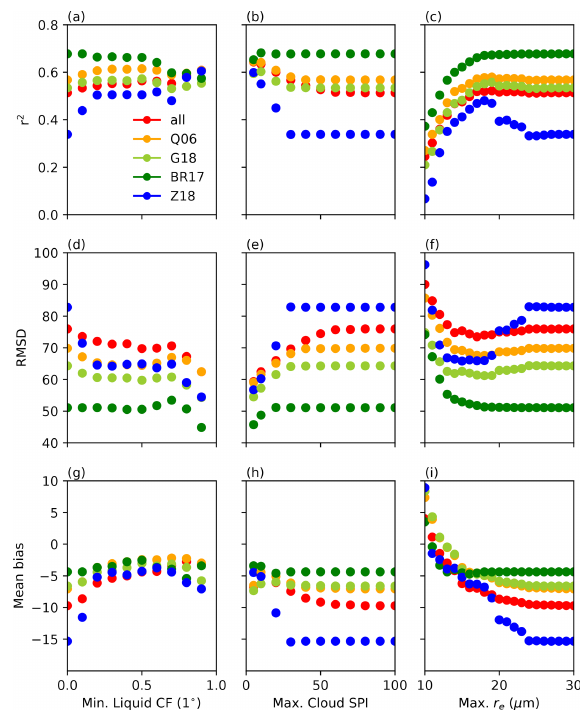
Figure 4. The impact of filtering by (a) large-scale liquid cloud fraction, (b) pixel-level cloud SPI and (c) the maximum permitted r e on the total r 2 for each sampling strategy. (d, e, f) As (a) , (b) and (c) but for the root mean squared deviation. (f, g, h) As (a) , (b) and (c) but for the mean